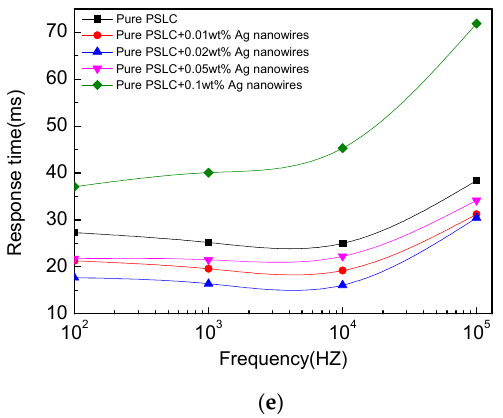
Figure 7. Frequency modulation of the Ag nanowire doped PSLC according to the Ag nanowire concentration: ( a , b , c ) F–T curve under 10 V, 20 V and 30 V, respectively; ( d ) threshold voltage V 10 under different frequency; and ( e ) response time under different frequency.